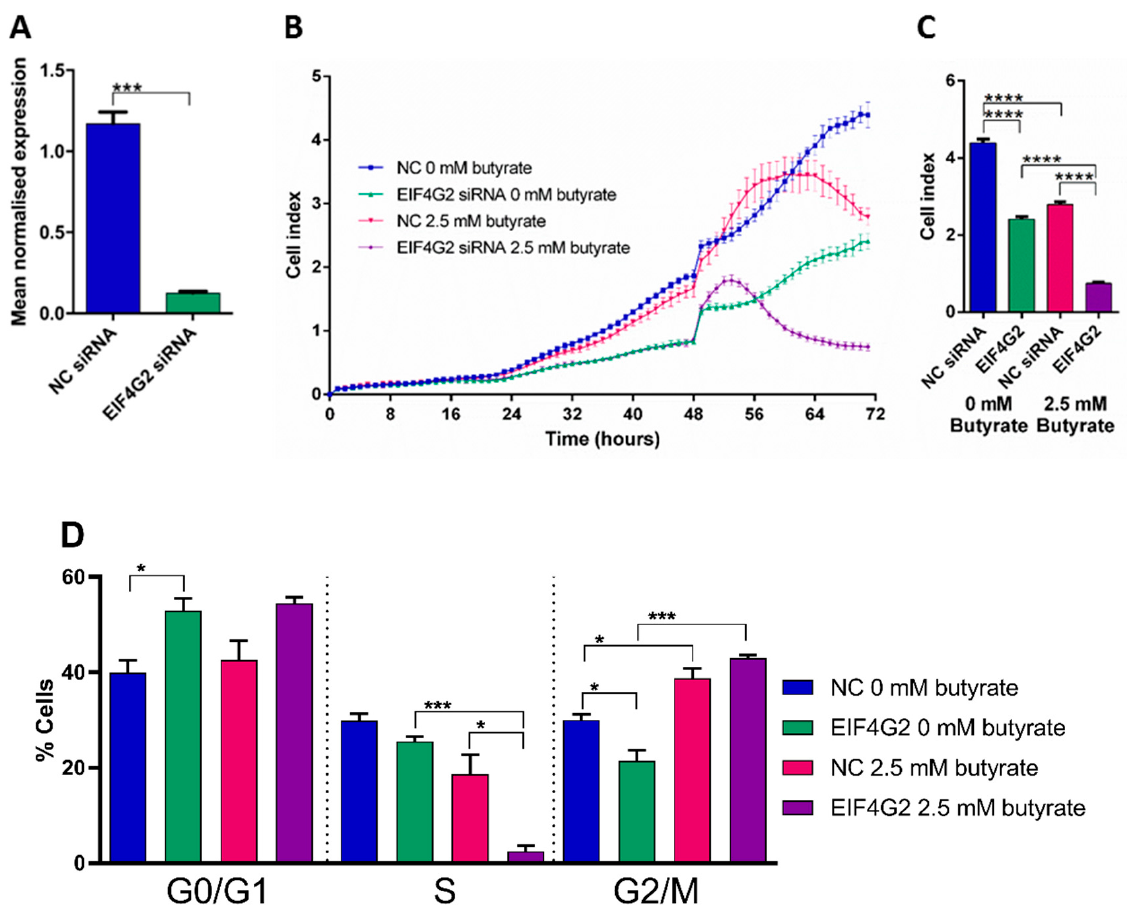
Figure 13. EIF4G2 siRNA knockdown efficiency in HCT116 cells. mRNA levels of EIF4G2 in CRC cells ( A ) HCT116 cells transfected with NC siRNA or EIF4G2 siRNA for 72 h. The mean mRNA levels ± SEM ( n = 3) are represented, and their expression is normalized to the geometric mean of three reference genes, ACTB, B2M and GAPDH. Real-time cell index measurements using the xCELLigence RTCA platform, in ( B ) HCT116 cells transfected with NC or EIF4G2 siRNA for 48 h, followed by 24 h of treatment with 0 mM or 2.5 mM butyrate, over a 72 h post-transfection period. ( C ) The mean ± SEM ( n = 4) is shown at 72 h post-transfection with EIF4G2 siRNA. ( D ) Flow cytometry analysis of the cell cycle in siRNA transfected HCT116 cells after 24 h of butyrate treatment. Bar charts showing the cell cycle analysis of HCT116 cells reverse-transfected with EIF4G2 siRNAs for 48 h, followed by 24 h of treatment with 0 mM or 2.5 mM butyrate, over a 72 h post-transfection period. Cells were stained with propidium iodide, and cell percentage measured using the Cytoflex flow cytometer. The mean ± SEM ( n = 3) is shown. Significant results are indicated by * p < 0.05, *** p < 0.001, **** p < 0.0001. NC = negative control mimic.